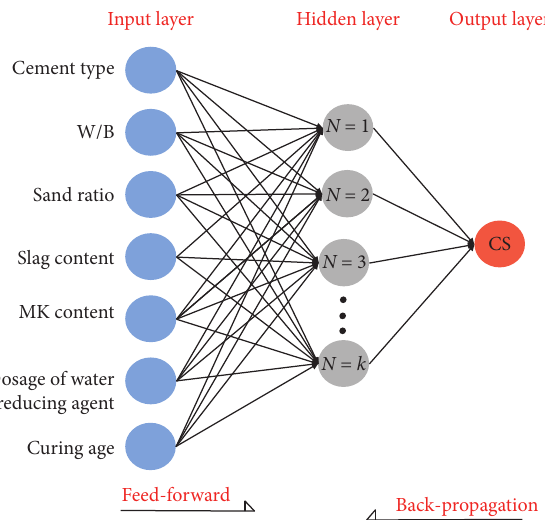
Figure 4: Feed-forward and backpropagation of